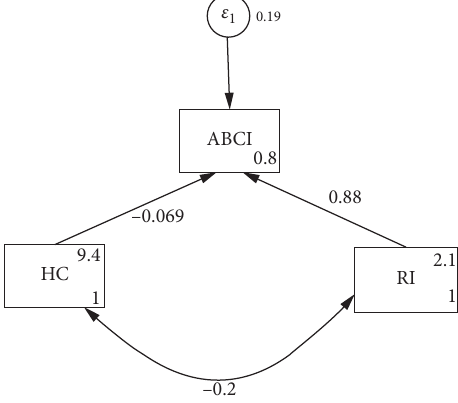
Figure 7: The magnitude of the effectiveness of RI and HC over